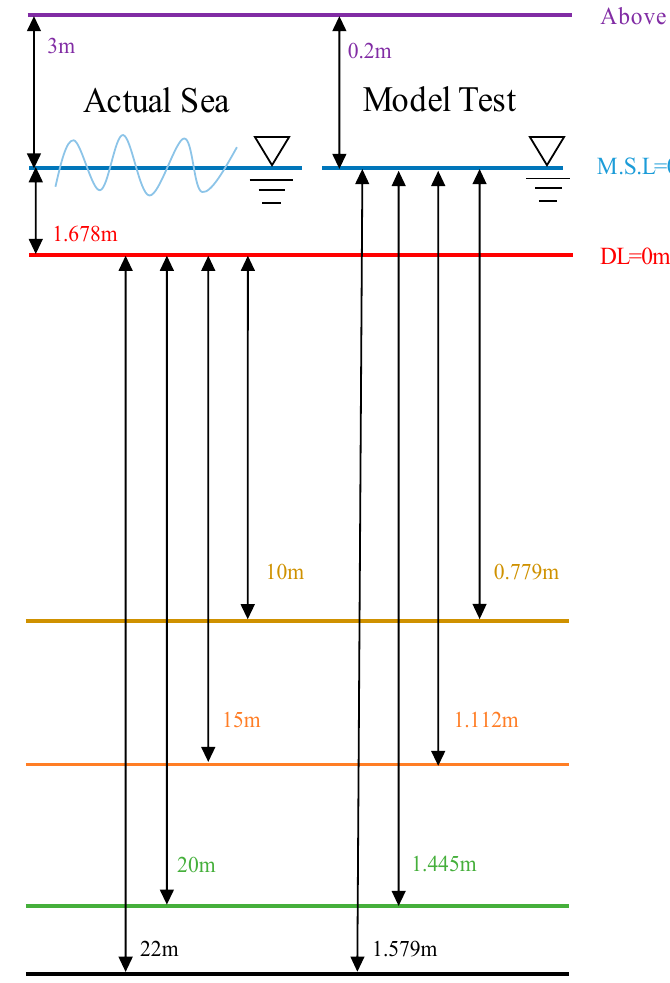
Figure 8. Actual and 1/15 scale-down experimental conditions.